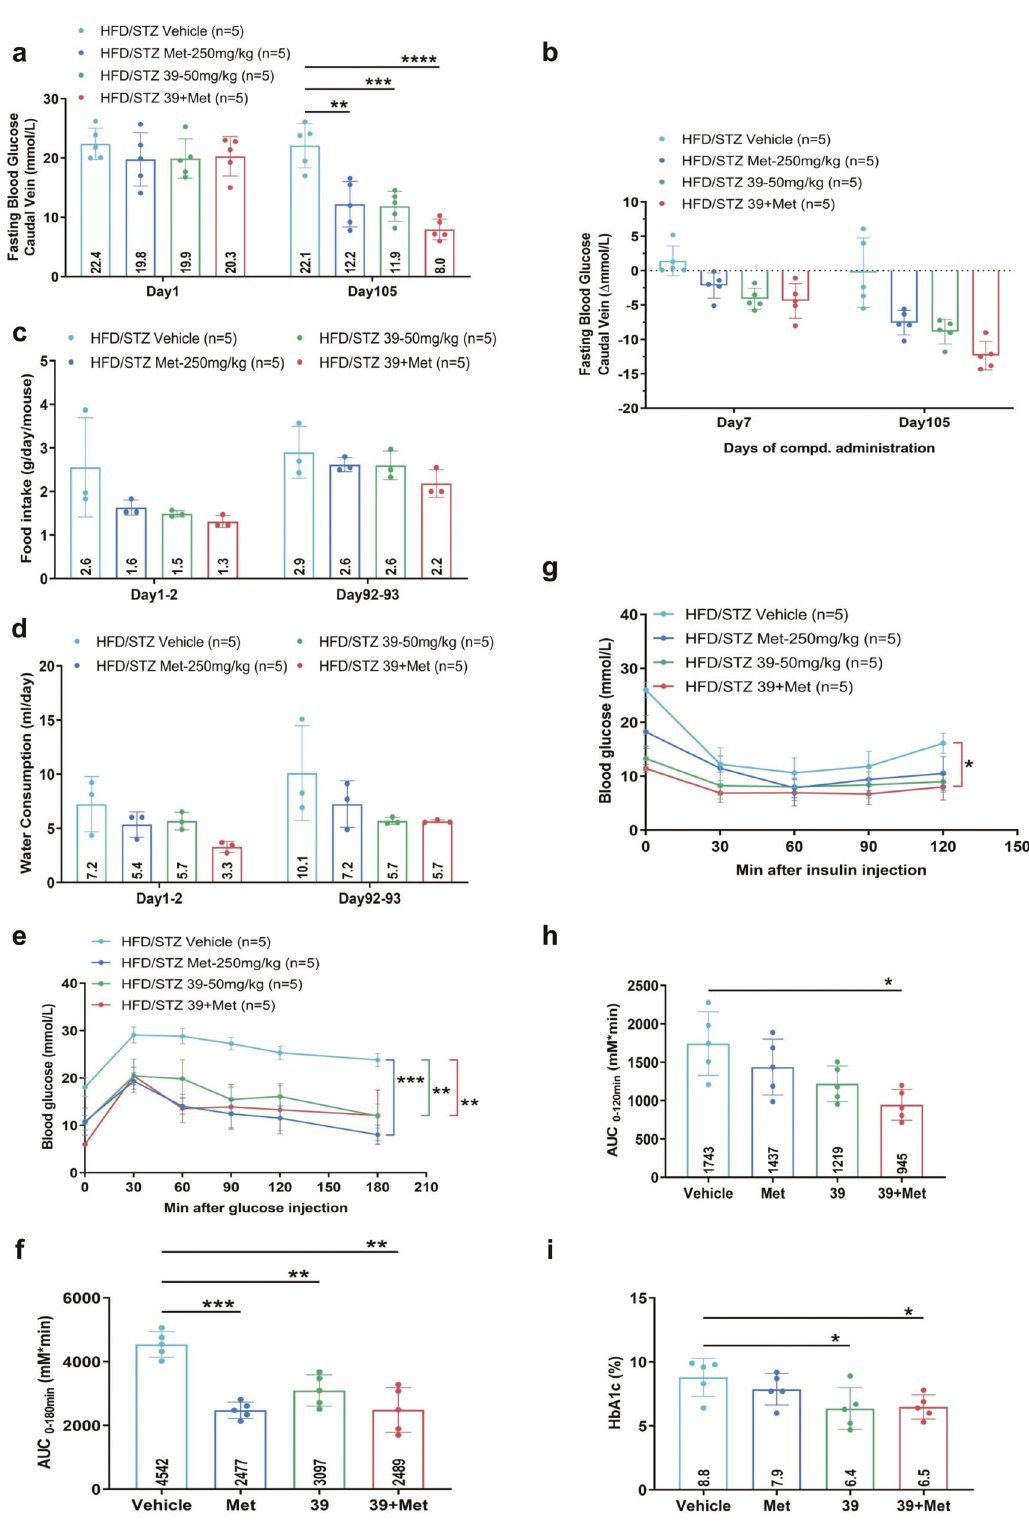
Fig. 6 Combination of IHMT-MST1-39 and metformin decreases hyperglycemia progression in HFD/STZ-induced mouse model of T2D. a – d Fasting blood glucose (caudal vein), food intake and water consumption measurements for once a week. e , f Intra-peritoneal glucose tolerance test (IPGTT) performed during 0 min and 180 min after glucose injection. Respective area-under-the-curve (AUC) shown in f . g , h Intra-peritoneal insulin tolerance test (IPITT) performed during 0 min and 120 min post insulin injection. Respective area-under-the-curve (AUC) shown in h . i HbA1c level was measured by Chemray-240/800. Data were expressed ±SEM. * p < 0.05, IHMT-MST1-39 compared with vehicle group mice; P values determined by Student ’ s t test